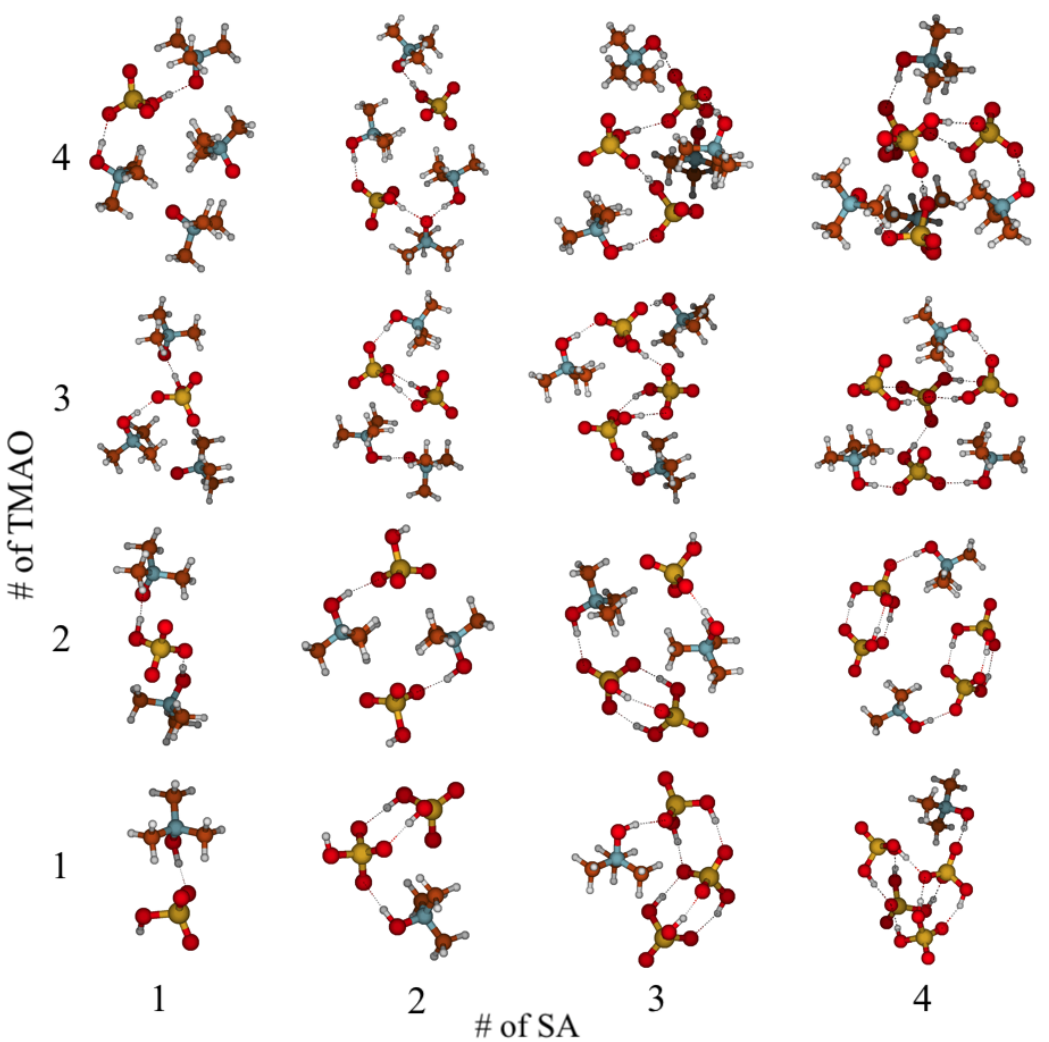
Figure 5. Molecular structures of sulfuric acid–trimethylamine oxide clusters. Color coding: Brown is carbon, blue is nitrogen, red is oxygen, yellow is sulfur, and white is hydrogen.